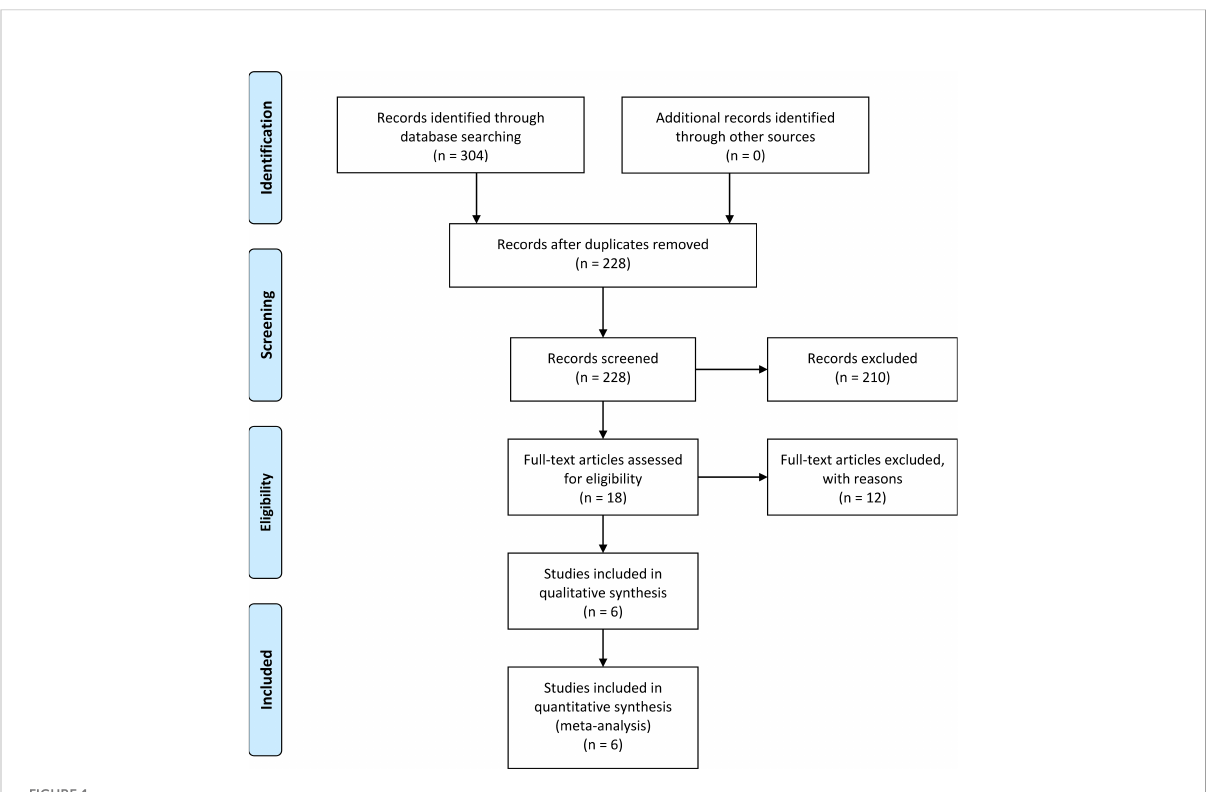
FIGURE 1 Flow chart of the selection process of the